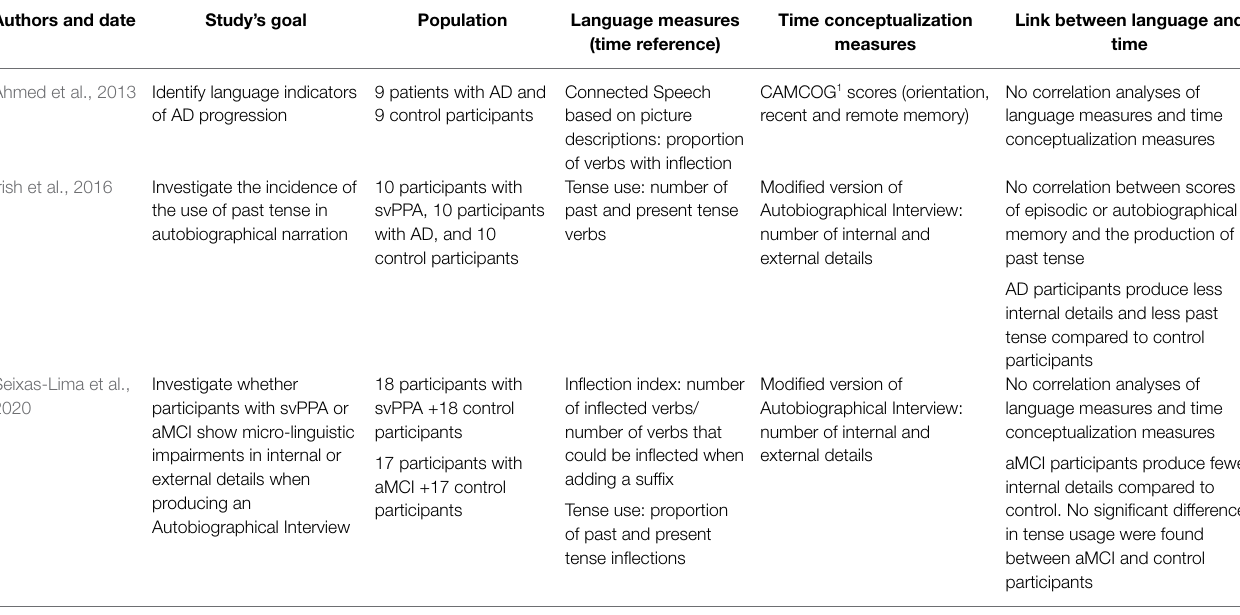
TABLE 3 | Characteristics of the studies included in the systematic